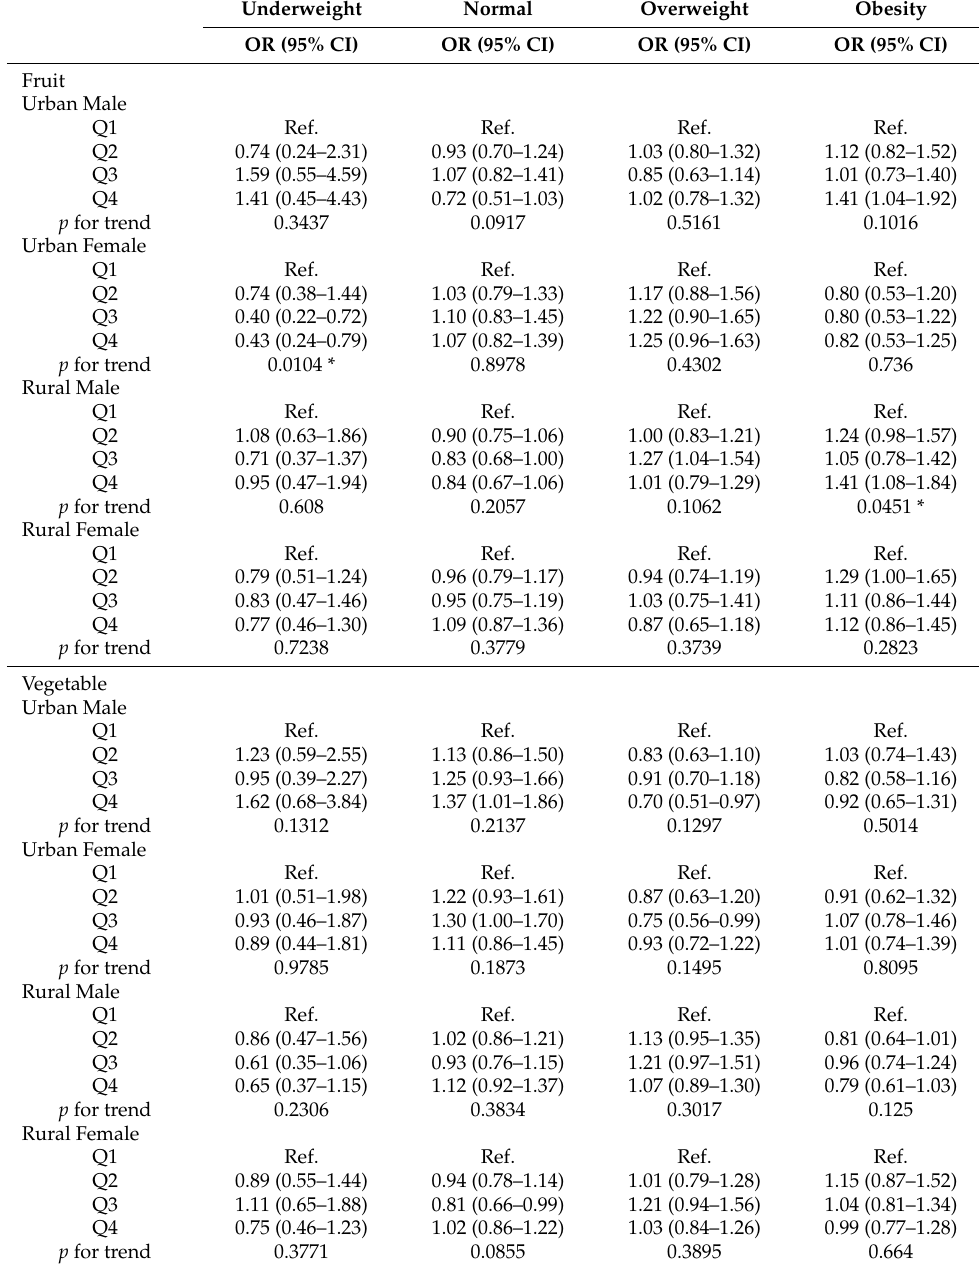
Table 5. Association between fruit and vegetable intake levels and weight status. Underweight Normal Overweight